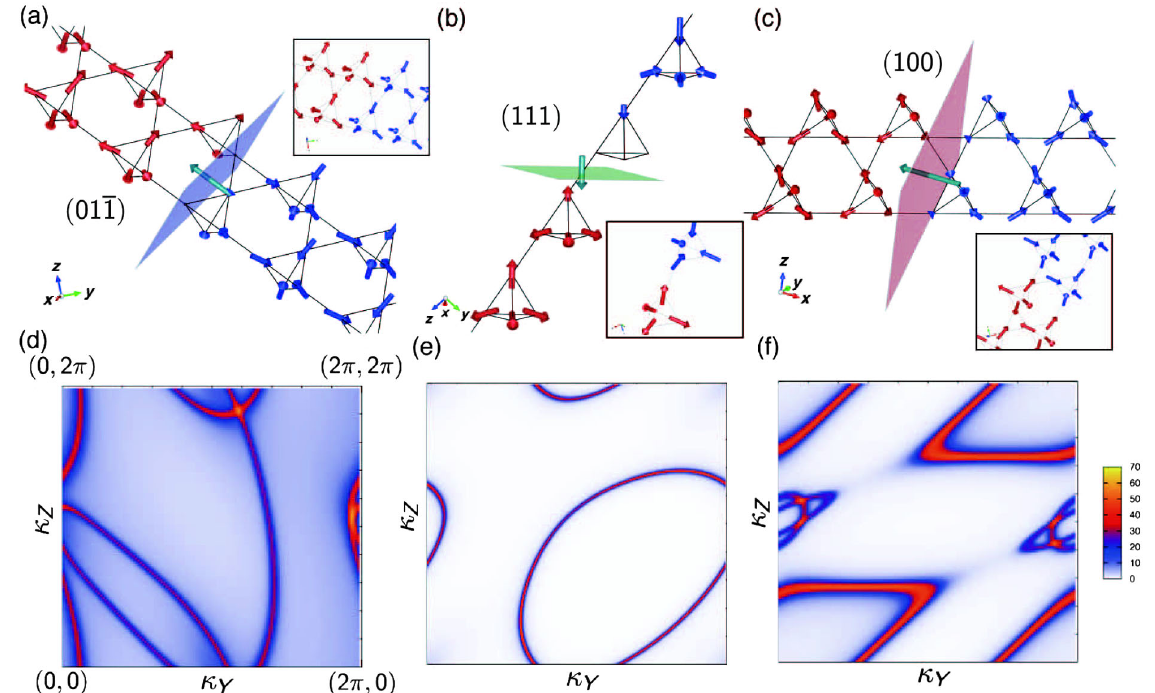
01¯1 FIG. 6. Magnetic domain walls and domain-wall states. (a) – (c) Optimized magnetic structures for ( ), (111), and (100) domain T=t ¼ 0 . 1 . The length and direction of walls, obtained from initial configurations shown in the insets, for U=t ¼ 4 , ζ =t ¼ − 0 . 2 , and k B the arrows are determined by optimized unrestricted Hartree-Fock solutions. We note that only a part of the supercells nearby the domain walls is illustrated. Uniform magnetization m 0 induced by the insertion of the domain walls and the intersection of the domain walls with the supercells are also illustrated as bold green arrows and shaded planes, respectively. (d) – (f) Spectral functions projected to the domain 01¯1 T=t ¼ 0 . 1 , with a finite Lorentzian walls for (d) the ( ) domain wall, (e) the (111) domain wall, and (f) the (100) domain wall, for k B width δ ¼ 0 . 01 t . At this temperature, bulk Weyl points do not exist any more. Every domain wall contributes to in-gap states at the chemical potential or the Fermi level, forming open two-dimensional Fermi surfaces. As a consequence of the pair annihilation of the Weyl points shown in Fig. 3(c), the Fermi arcs for the domain walls are now closed at this temperature. The complexity of the domain- wall Fermi surfaces originates from the following fact: Depending on the orientation of the domain walls, there are many choices of how to connect the Weyl points with the loci of the domain-wall zero